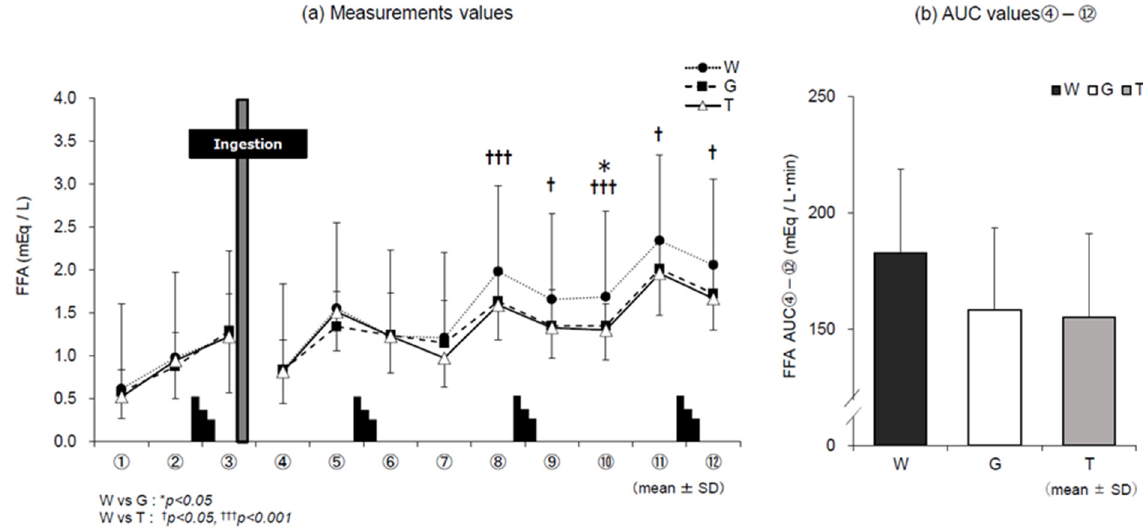
Figure 6. Changes in FFA levels for each trial. W—water; G—glucose; T—trehalose. Changes in free fatty acid level (FFA) in each trial (water (W), glucose (G), trehalose (T)). Comparison between ( a ) measurements and ( b ) area under the curve (AUC) values ④ – ⑫ of each trial ( n = 12). W vs. G: * p < 0.05; W vs. T: † p < 0.05, ††† p < 0.001.